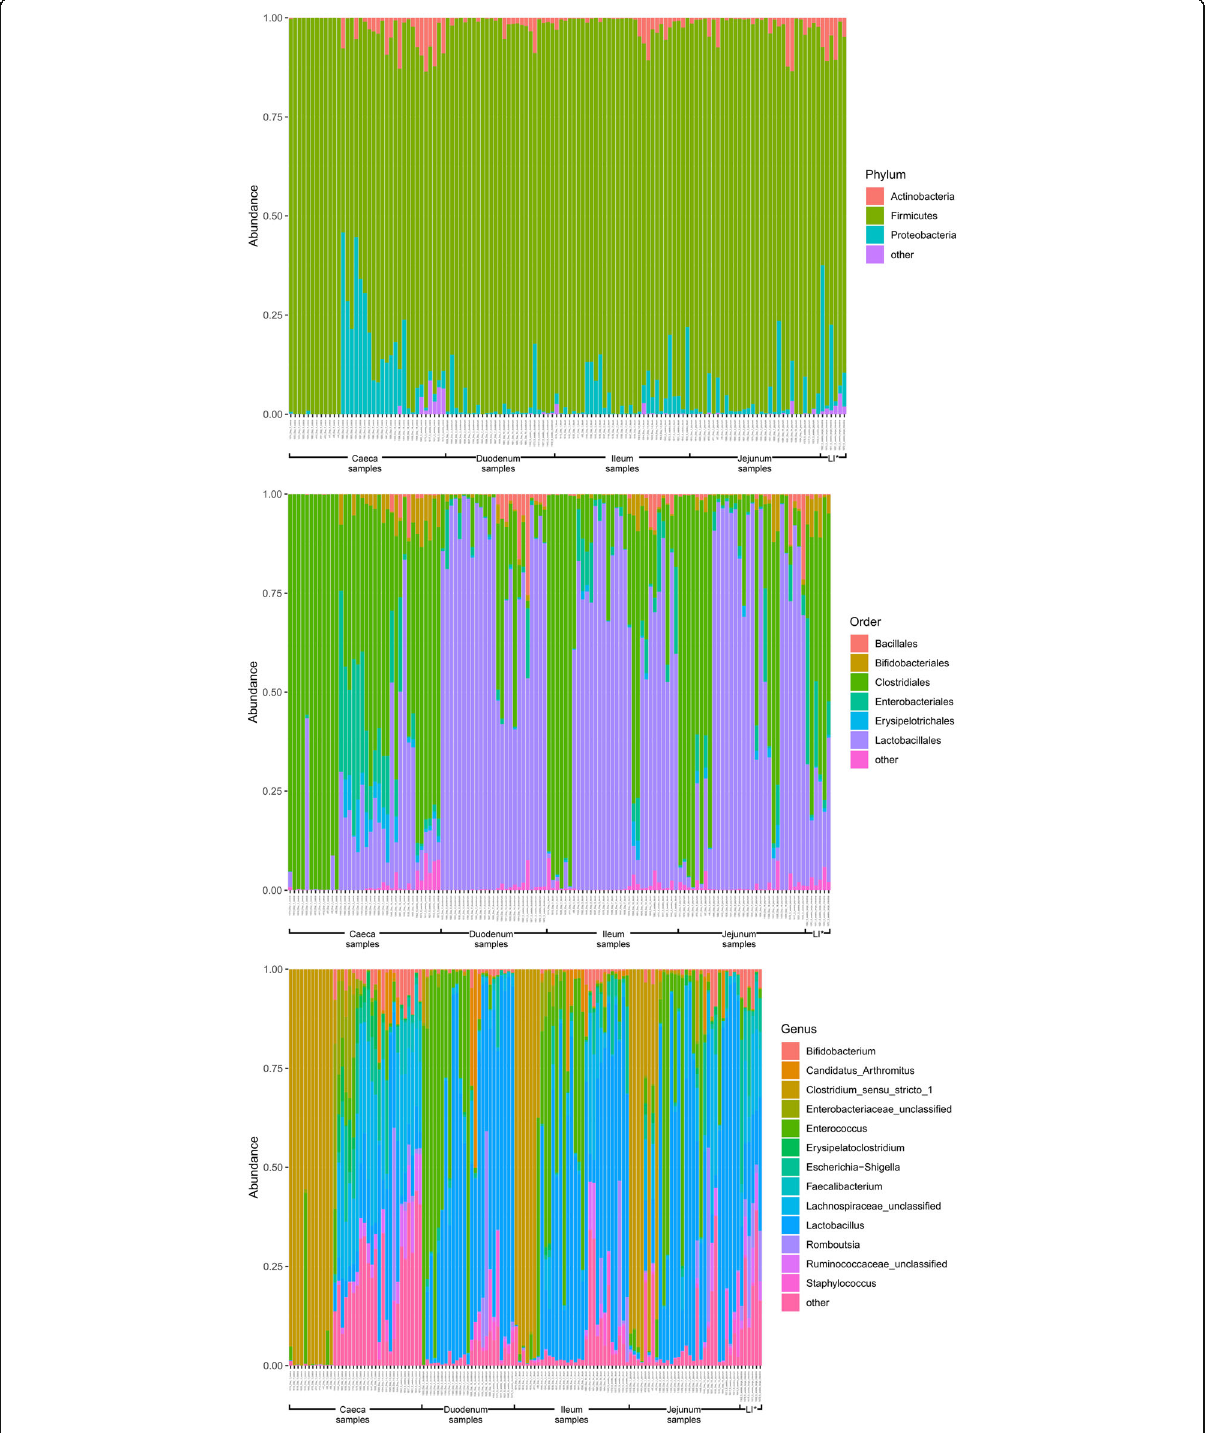
Fig. 3 Abundance of bacterial phyla, orders and genera within chicken intestinal samples (subsampled to 10,000 reads). * LI = large